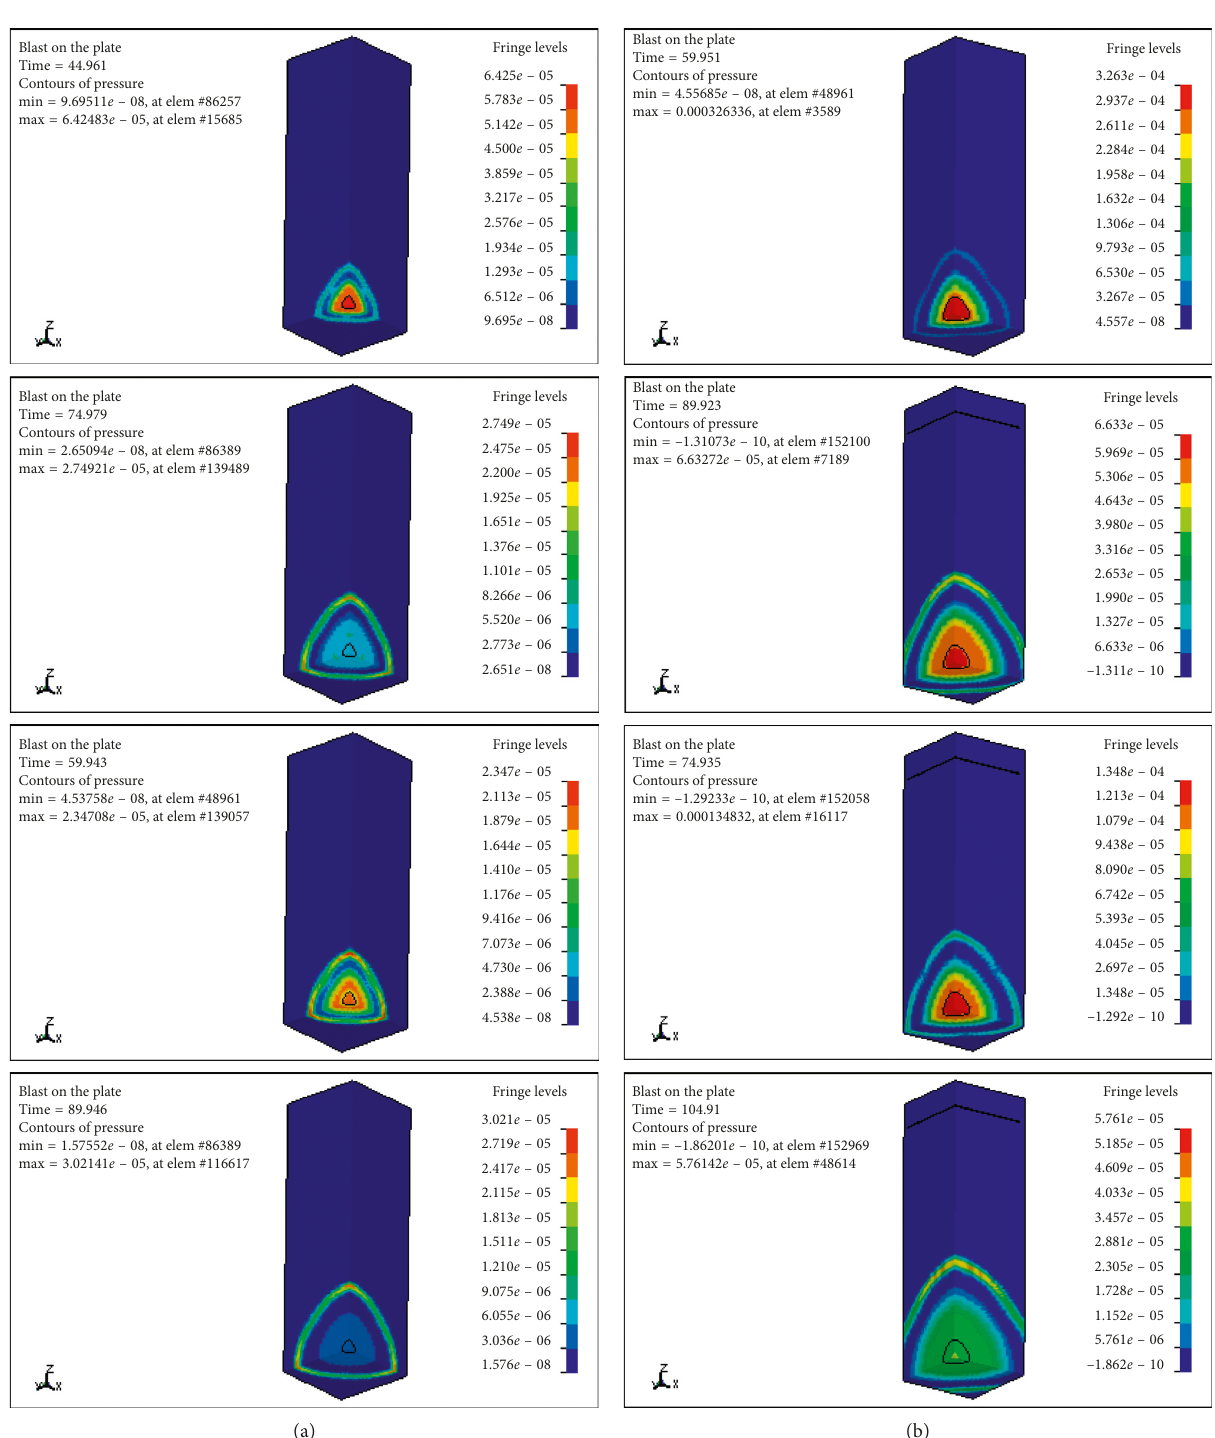
Figure 12: Waveform of a spherical charge explosion. Explosion waveform of the (a) working condition 1 and (b) working condition